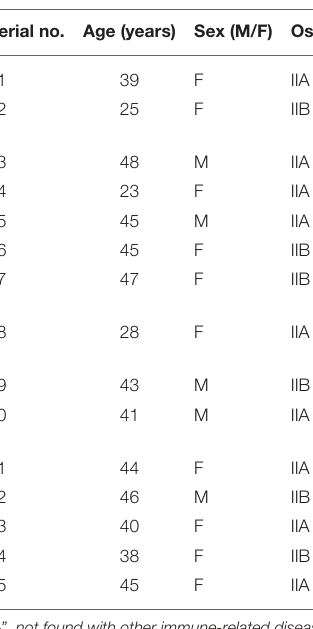
TABLE 1 | Specimen collection of patients with